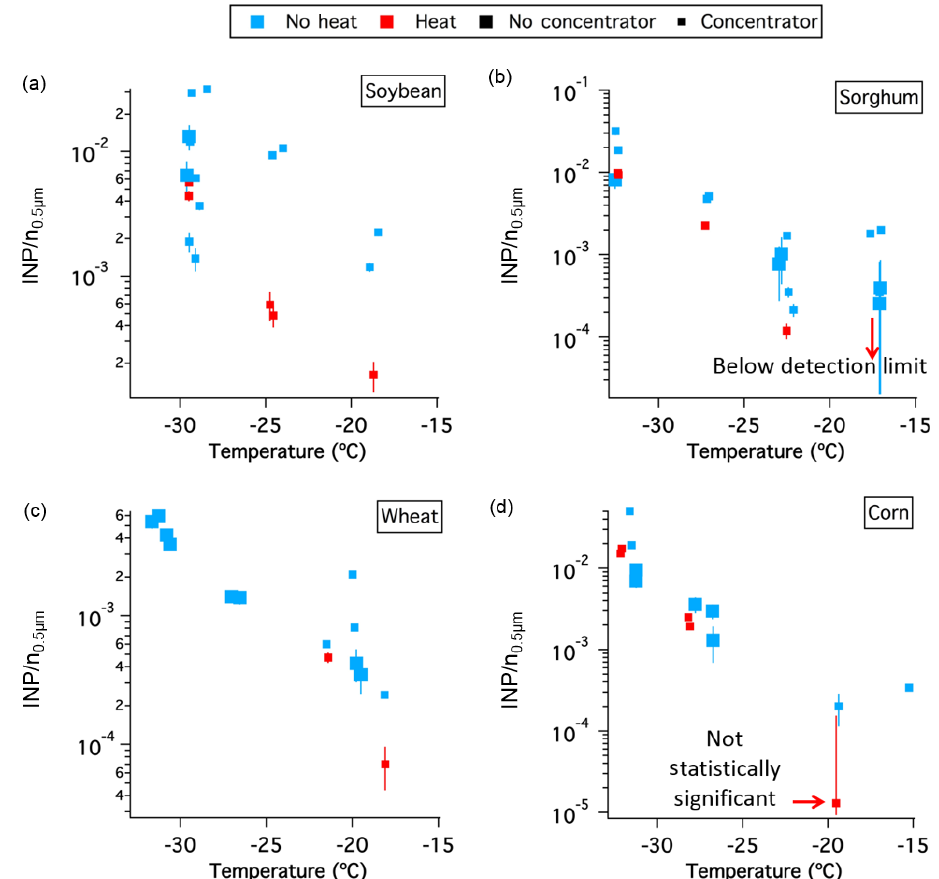
Figure 5. The fraction of INPs out of the total number of particles greater than 0.5µm as measured by the CFDC ( n 0 . 5µm ) is plotted against CFDC operating temperature for four crop harvests: soybean (a) , sorghum (b) , wheat (c) , and corn (d) . Data collected through the heating tube at 300 ◦ C are shown in red and non-heated data are in blue. The larger markers represent periods sampled without the concentrator, and the smaller markers represent periods sampled through the concentrator. Note the difference in scale on the y axes.